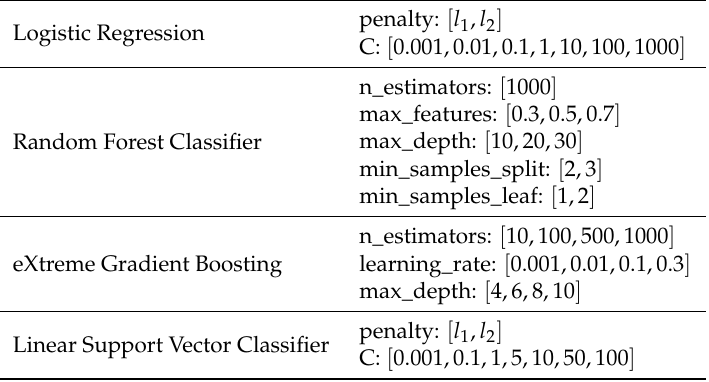
Table 2. Gridsearch hyperparameter space.